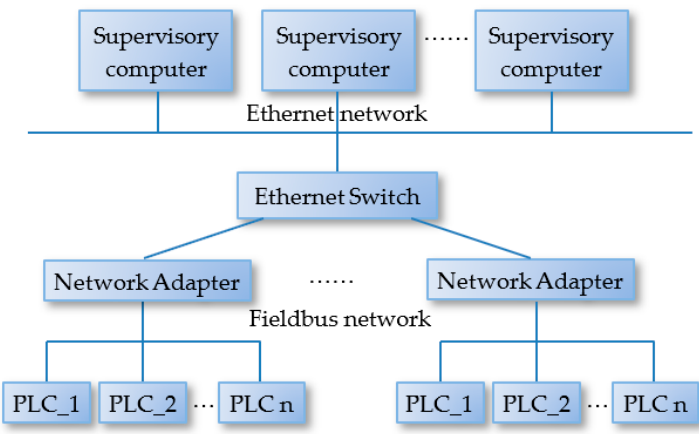
Figure 1. A typical networked control monitoring system using programmable logic controllers (PLCs.).